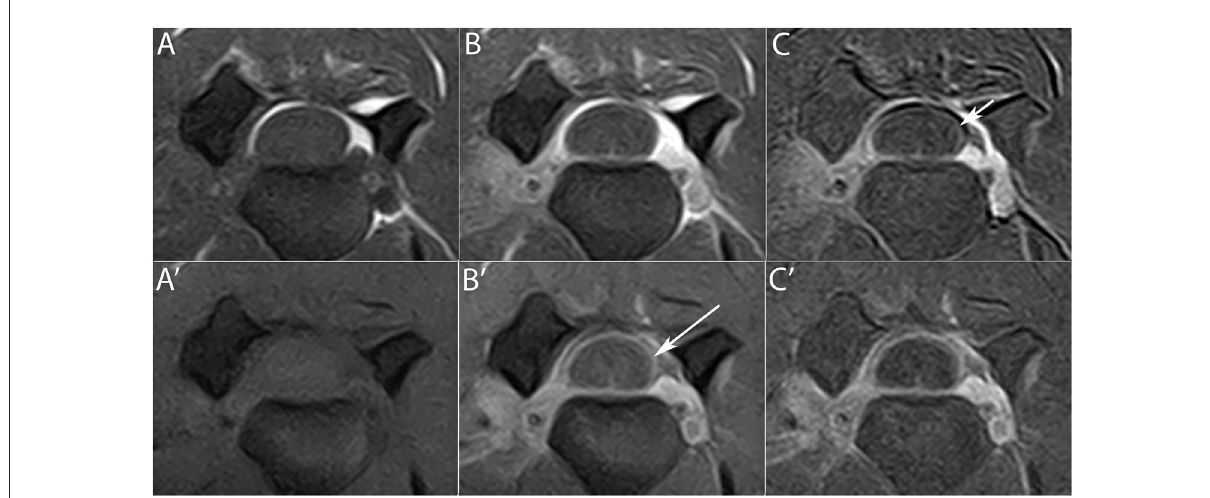
FIGURE3 Transverse T1W (upper row) and T1 FAT SAT (lower row) images pre- (A,A’) and post- (B,B’) contrast administration at the level of the C3–C4 intervertebral space. Meningeal enhancement is visible on the T1W images only with the application of the subtraction technique (C) (short arrow), while it is easily detectable in T1W FAT SAT images (B’) (long arrow). The subtraction technique in T1W FAT SAT images (C’) is therefore not necessary.